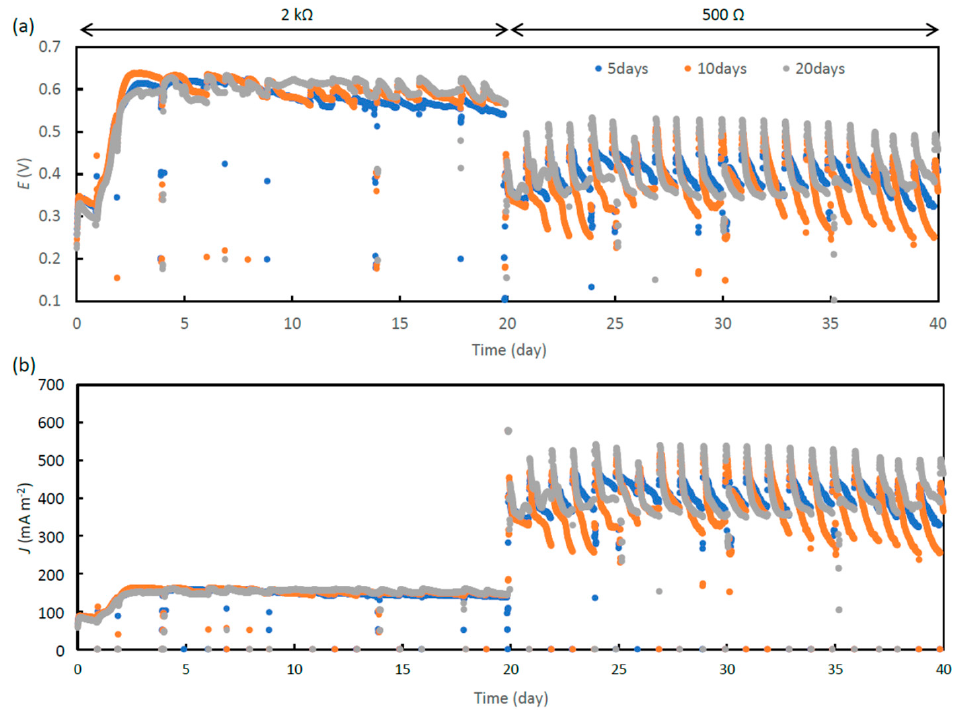
Figure 1. Representative curves showing changes in E ( a ), and J ( b ), for ADE-treating MFCs operated at HRTs of 5, 10 and 20 days. R ext was changed from 2000 Ω to 500 Ω on day 20. Polarization analyses were conducted to determine P max , the potential of power generation, for MFCs operated at the different HRTs, and representative polarization and power curves are presented in (a), (b) and (c) in Figure 2. From J and E values at which P max values were given in power curves, the optimum R ext ( R ext that generates the highest power) could be estimated, and this was 313, 375 and 350 Ω for MFCs operated at HRTs of 5, 10 and 20 days, respectively. From these estimates, it was considered that R ext of 500 Ω was close to the optimum for MFCs used in this study for the treatment of ADE. We, therefore, decided not to further decrease R ext in our experiments.